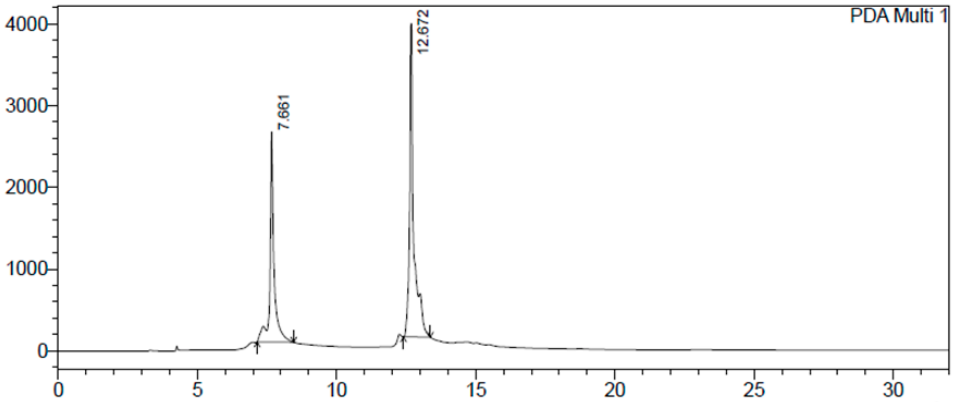
Figure 1. Chromatogram of the High Performance Liquid Chromatography with a Diode-Array Detector (HPLC-DAD) analysis of the investigated G5 fraction from Schinus terebinthifolius Raddi fruit extract (4.0 mg/mL) at wavelength of 254 nm. Analytical conditions: stationary phase: RP-18 reverse-phase column (5 μ m, 250 mm, 4.5 mm, Macherey-Nagel); temperature: 32 °C; mobile phase: A = purified water adjusted to pH 3.2 with phosphoric acid, B = acetonitrile; flow rate: 1.0 mL/min; detection: 254 nm; injection volume: 20 μ L; solvent composition during analysis: 0 ′ : 100% A; 5 ′ : 70% A; 10 ′ : 50% A; 15 ′ : 30% A; 20 ′ : 20% A; 25 ′ : 10% A; 30 ′ : 0% A; 32 ′ : stop.